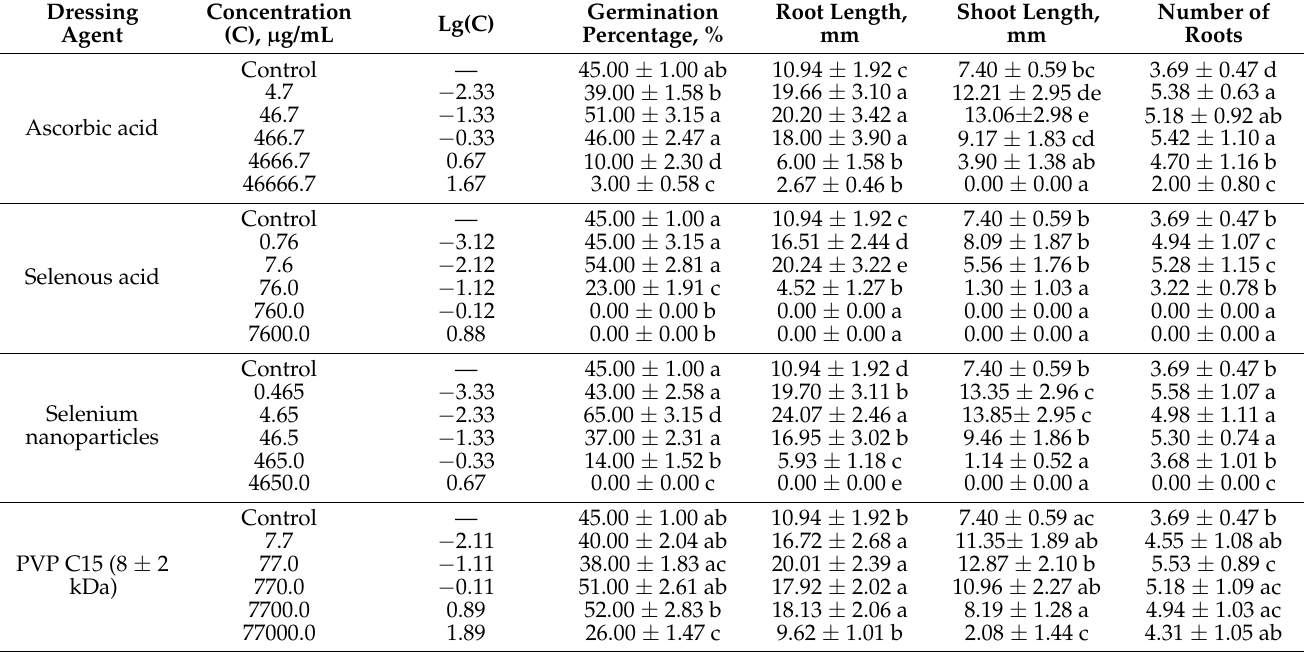
Table 3. Influence of the dressing agent’s concentration on the morphological and functional characteristics of Hordeum vulgare L.